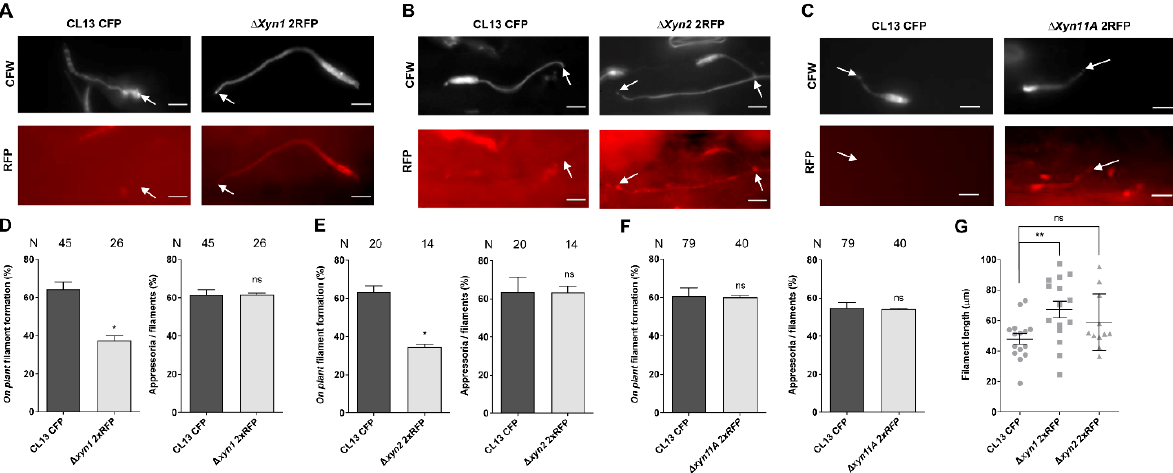
Figure 6. Filamentation on plant surface is reduced in the absence of Xyn1 and Xyn2. Maize seedlings were co-infected with CL13 CFP and CL13 2xRFP ( A , D , G ) ∆ xyn1 , ( B , E , G ) ∆ xyn2 , or ( C , F ) ∆ xyn11A mutant strains. After 18 h, infected leaves were stained with calcofluor white (CFW), and formation of filaments and appressoria was measured by scoring RFP fluorescence. Representative images of normally developed appressoria are shown in ( A – C ). Filament and appressoria efficiency are shown in ( D – F ). Length of filaments with appressoria is quantified in ( G ). White arrows indicate appressoria. Scale bar represents 10 µm. At least two leaves from two independent experiments were analyzed. T-test statistical analysis was performed (ns, not statistically significant; * p -value < 0.05; ** p -value < 0.01).